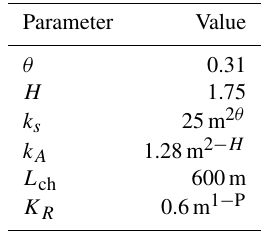
Table A1. Inyo Creek power-law profile model parameters. Table A2. Noyo River exponential profile model